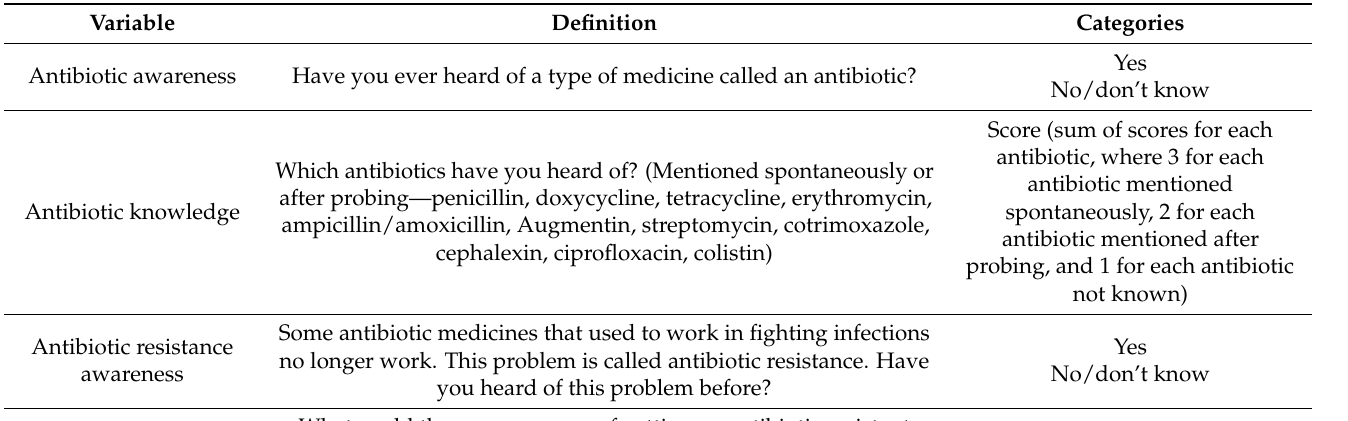
Table 4. Definitions of independent variables and their